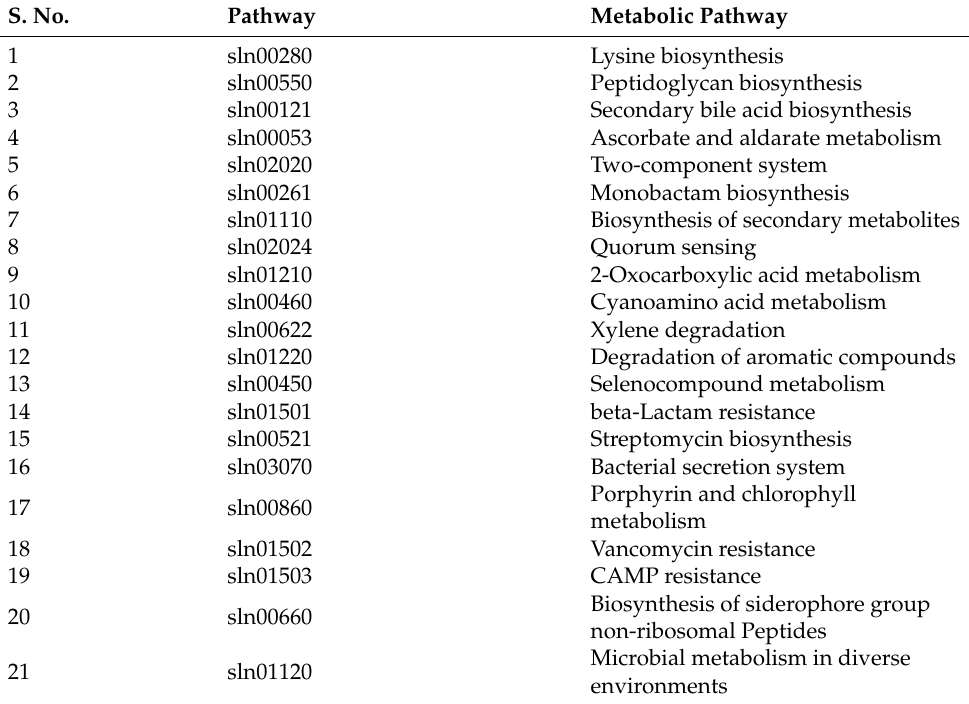
Table 2. Unique metabolic pathways of S. lugdunensis , along with pathway IDs.